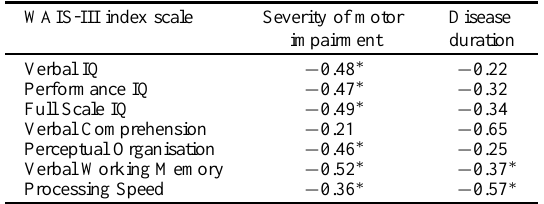
Table 4 Non-verbal cognitive flexibility inSCA-6groupandcomparison with control data Brixton test of Spatial Anticipation